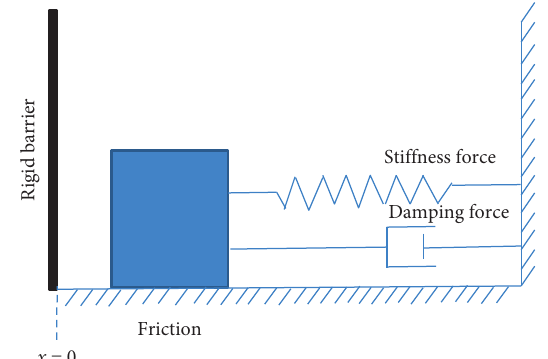
Figure 1: Schematic model of the system with impact and